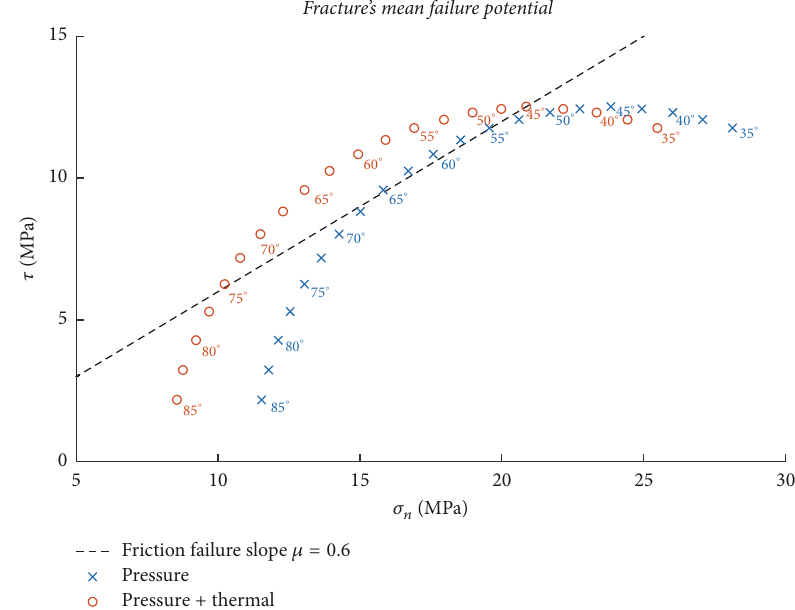
Figure11:Failurepotentialforrotatedfracturesduetothermalstress.ThefailurepotentialisdepictedintheclassicalMohr-Coulombdiagram. A fracture is eligible for slip if its corresponding point in the diagram touches/crosses the failure line (black dashed). Failure occurs only in a narrow range of orientations with the selected injection pressure. After 10 days of injection, thermal stress leads to possible slip in a wide range of orientations.